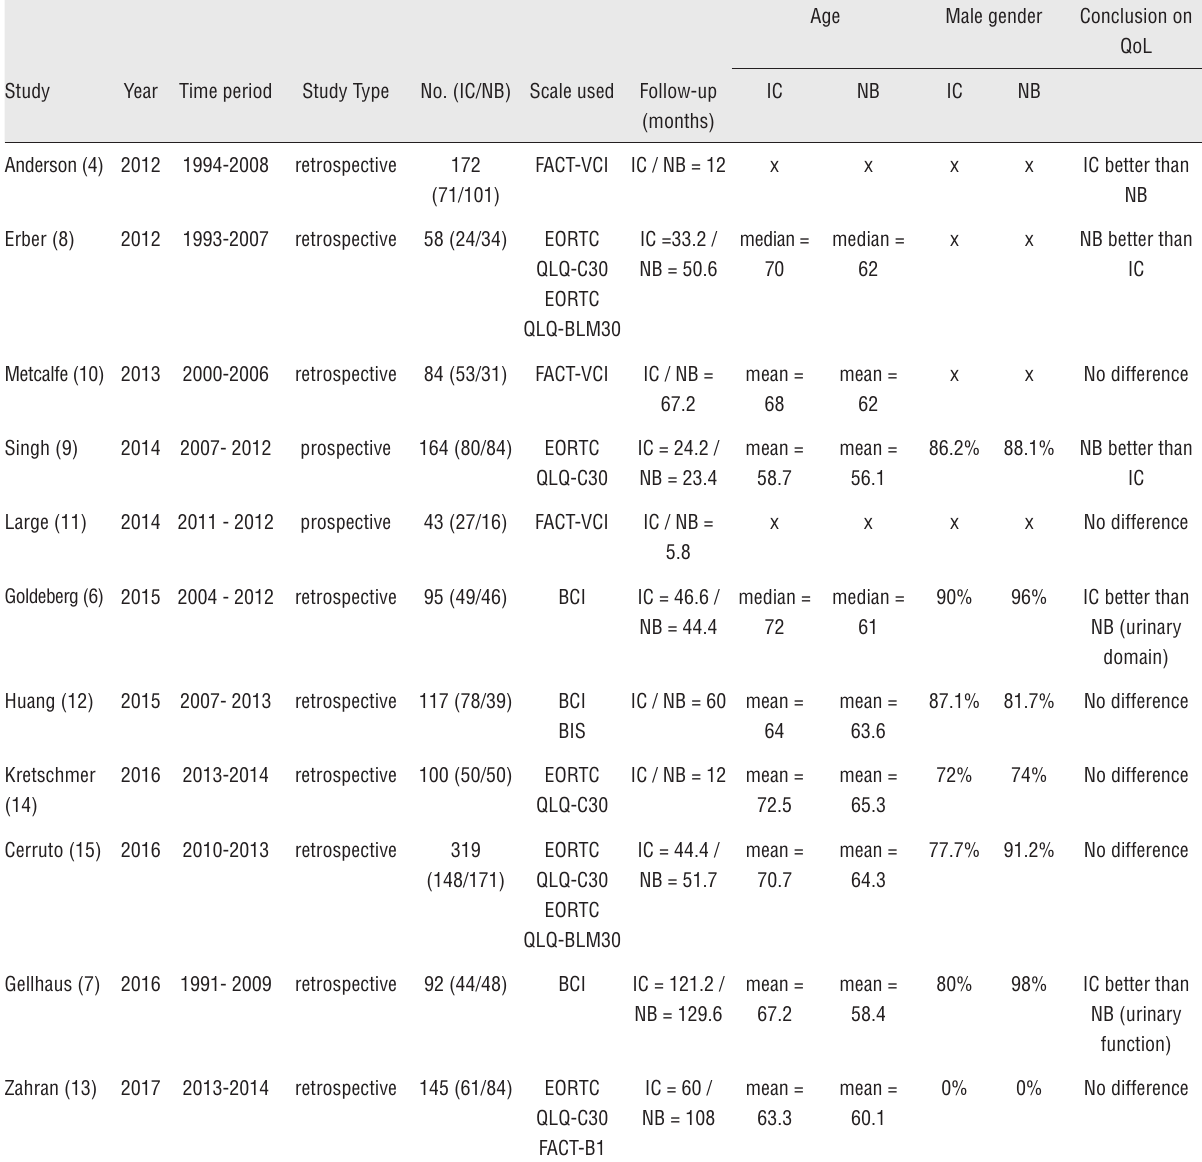
Table 3 – Characteristics of included